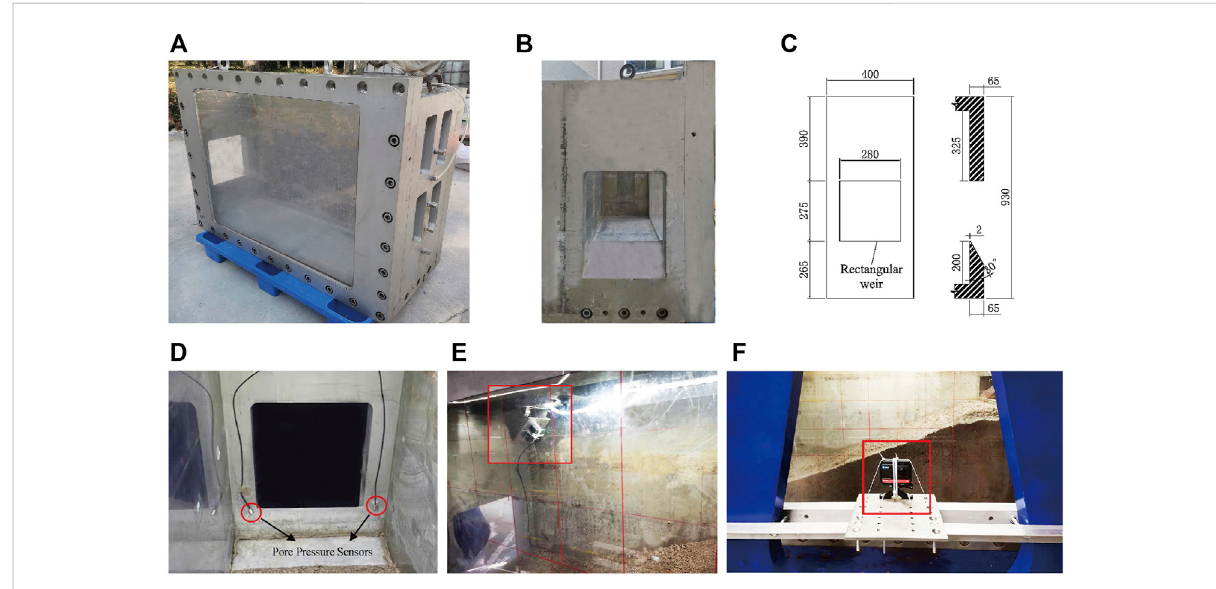
FIGURE 2 The special model box, layout of the pore pressure sensors and the image-recording devices. (A) Photograph of the model box (B) Photograph of the rectangular weir. (C) Schematic diagram of rectangular weir (unit: mm). (D) The pore pressure sensors. (E) Camera No. 1. (F) Camera No.